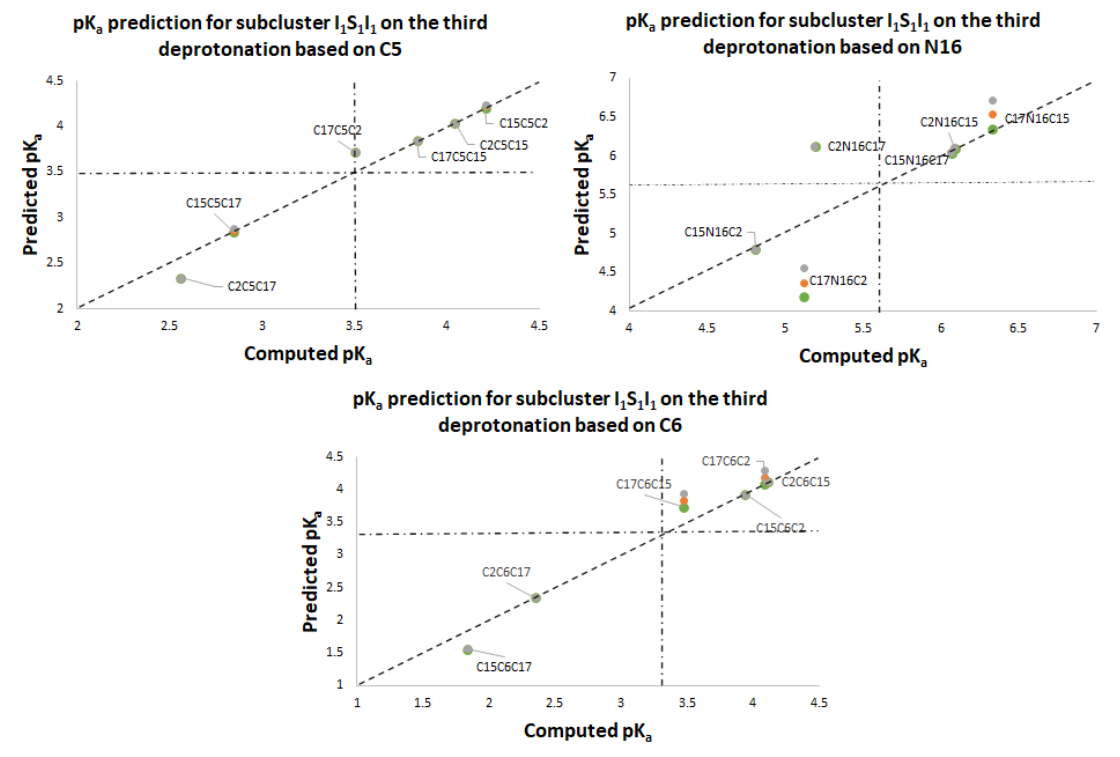
Int. J. Mol. Sci. 2023 , 23 , x FOR PEER REVIEW 21 of 36 Figure 18. pK a prediction for the third deprotonation on the subclusters I 1 S 1 I 1 based on C5, N16, and C6. Predictions are marked as gray (max), orange (mean), and green (min).